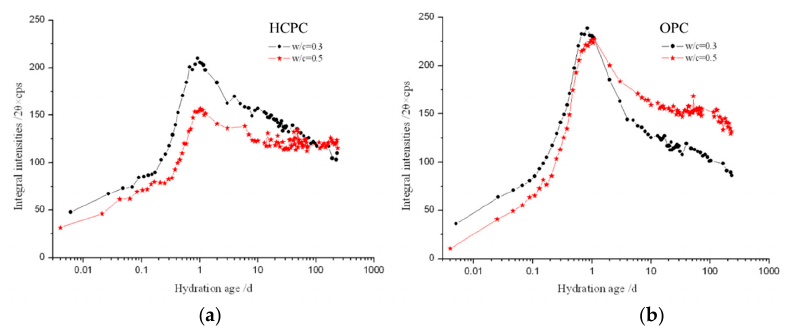
Figure 6. Plot of the integral intensities of the AFt’s diffraction peak of the HCPC ( a ) of the OPC ( b ). Compared with the hydrated specimens with w/c = 0.5, in the specimens with w/c = 0.3, the AFt content keeps decreasing continuously after it reached the maximum value without